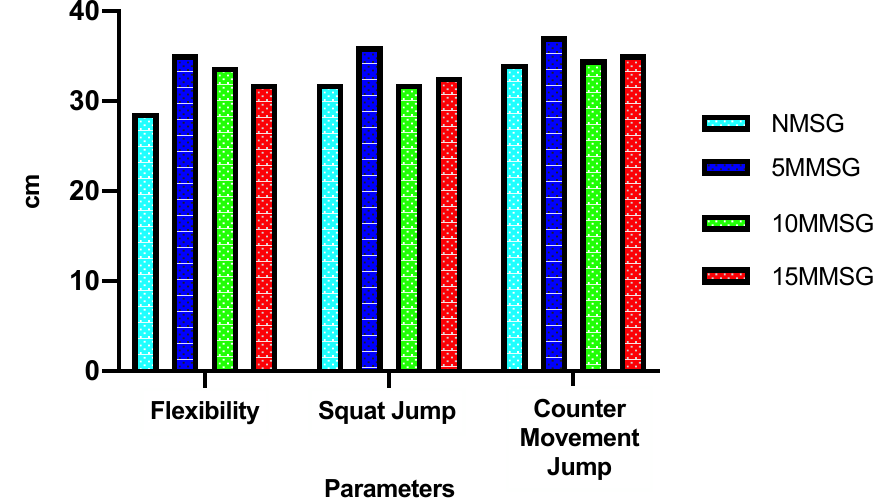
Figure 2. Flexibility, squat jump and counter movement jump performance of different massage